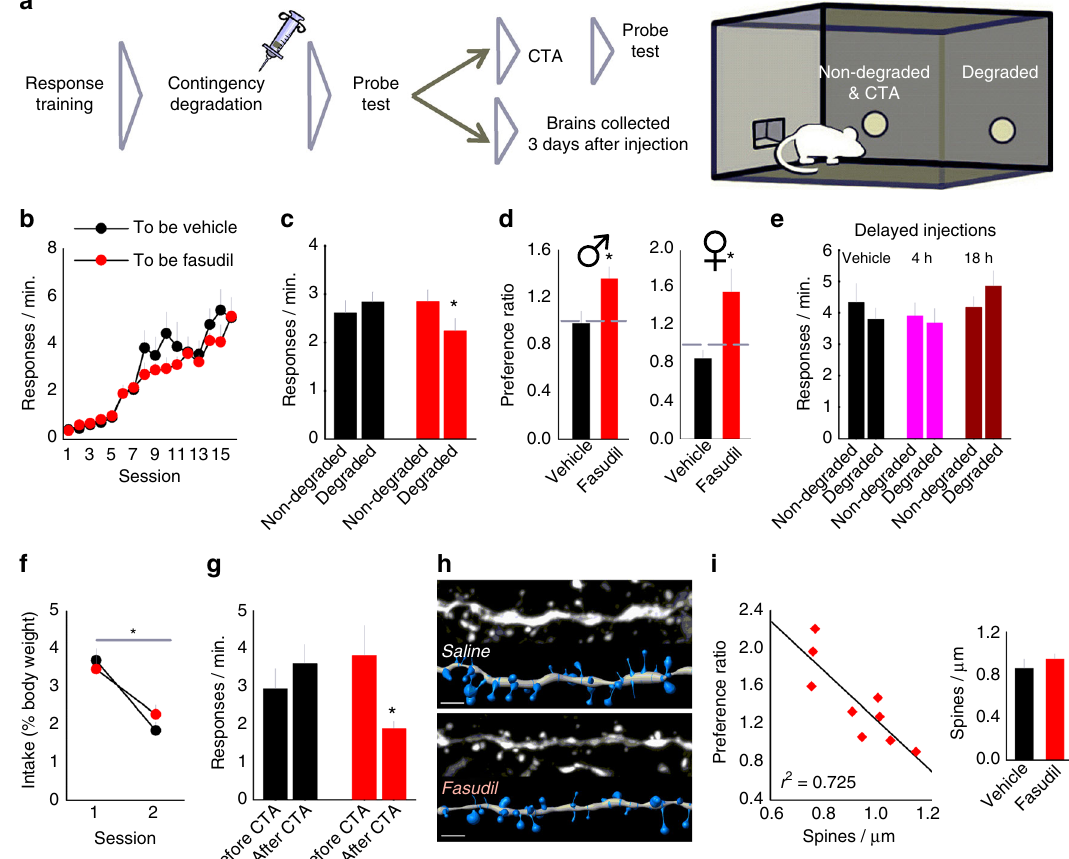
Fig. 2 ROCK inhibition enhances action – outcome decision making. a Experimental timeline: mice were trained using random interval (RI) schedules of reinforcement to induce habit-based behavior. Immediately following instrumental contingency degradation, mice were given a systemic injection of either vehicle ( n = 15) or the ROCK inhibitor fasudil ( n = 17). Following a probe test, brains were either collected or mice were tested further for sensitivity to outcome value using lithium chloride (LiCl)-based conditioned taste aversion (CTA). b Groups did not differ during instrumental response acquisition.